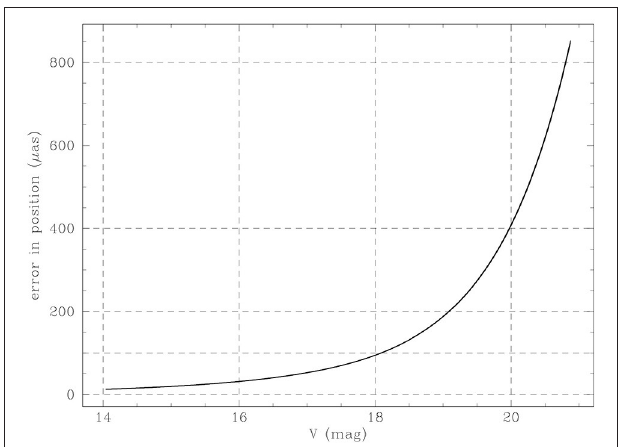
FIGURE 2 | Errors in integrated G (white light), RP (red photometer), and BP (blue photometer) magnitudes per transit, as a function of V magnitude, estimated from G magnitude as explained in Figure 1 . Errors were estimated from Equations (9–13) in Prusti et al. (2016) using N obs = 1. Combining blocks of N obs transits obtained on timescales of days or weeks reduces the errors by p N obs .